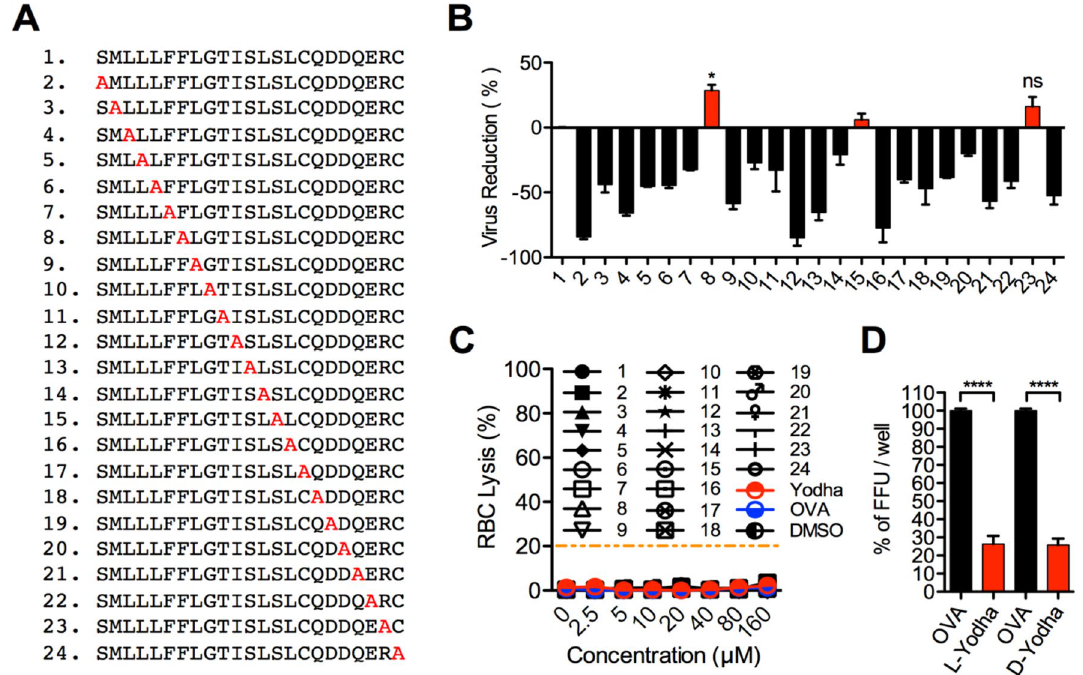
T-test two tailed p-value (*) p = 0.021, (ns) Non significant p = 0.1553. ( C ) Each of the alanine scan mutants was tested for cytotoxicity test using human red blood cells. ( D ) Both, the L-enantiomer of Yodha (L-Yodha),